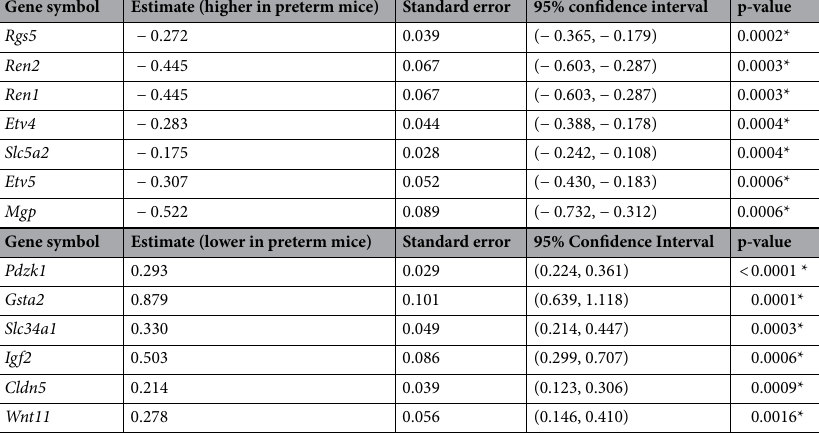
Table 1. Differentially expressed genes at 27 dpc. The p values and confidence intervals were based on the two-sample t-test with pooled variance with an adjust p value <